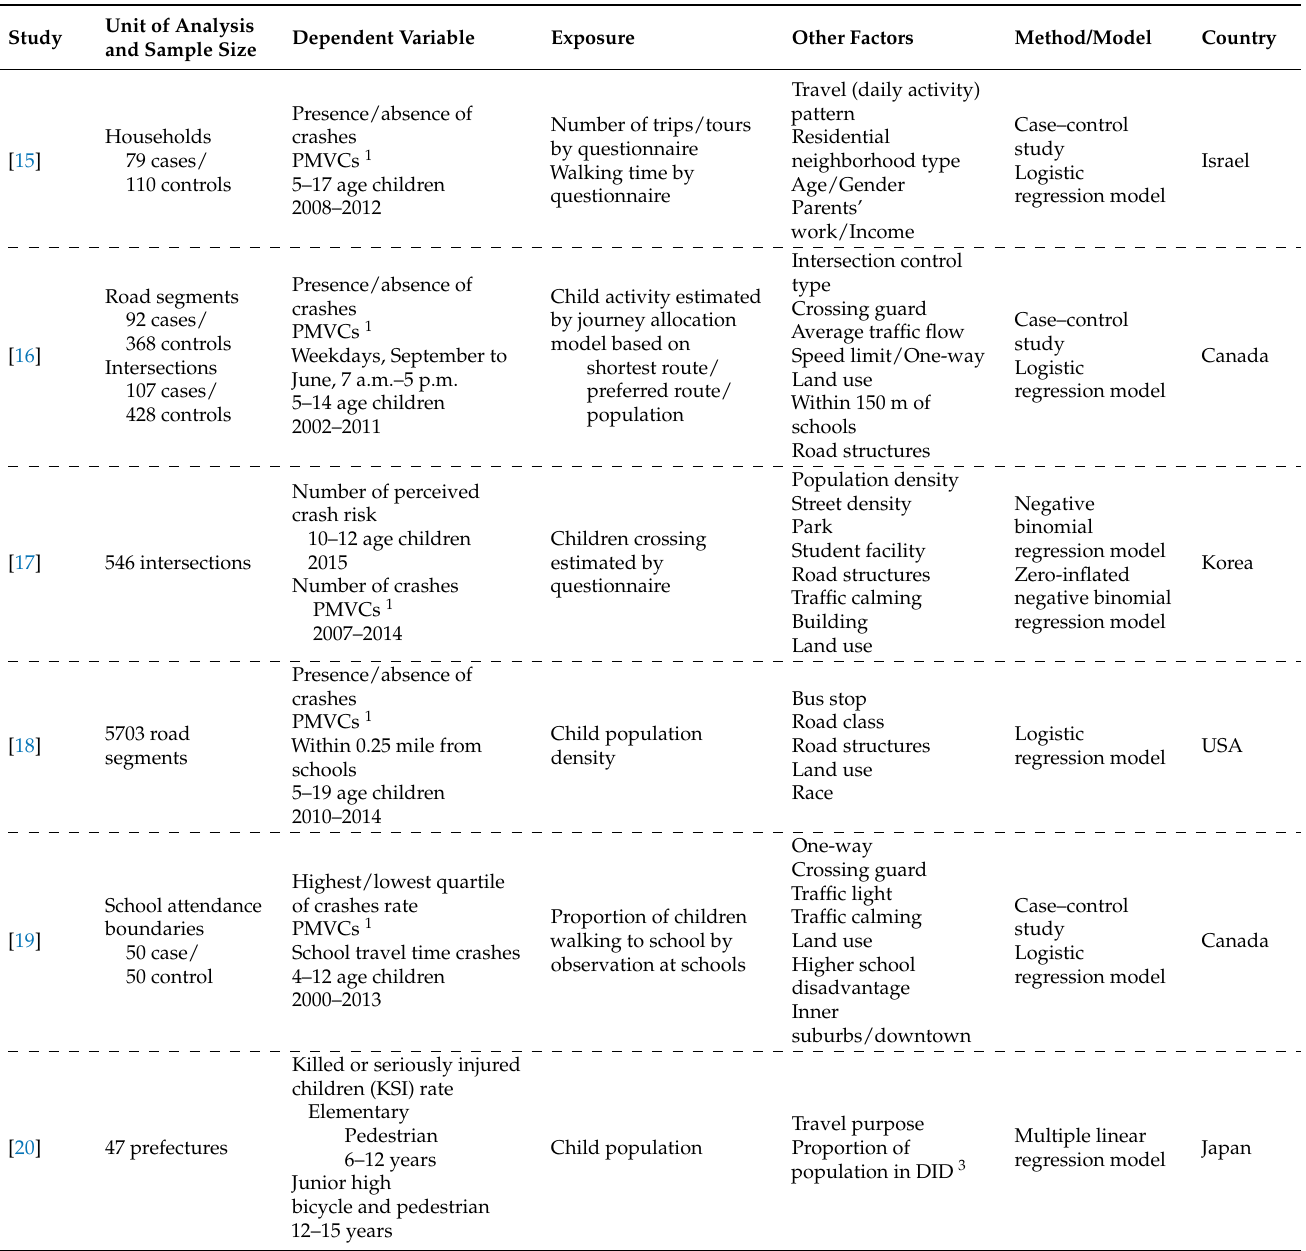
Table 1. Main previous studies using a statistical modeling approach for the assessment of accident risk involving children by